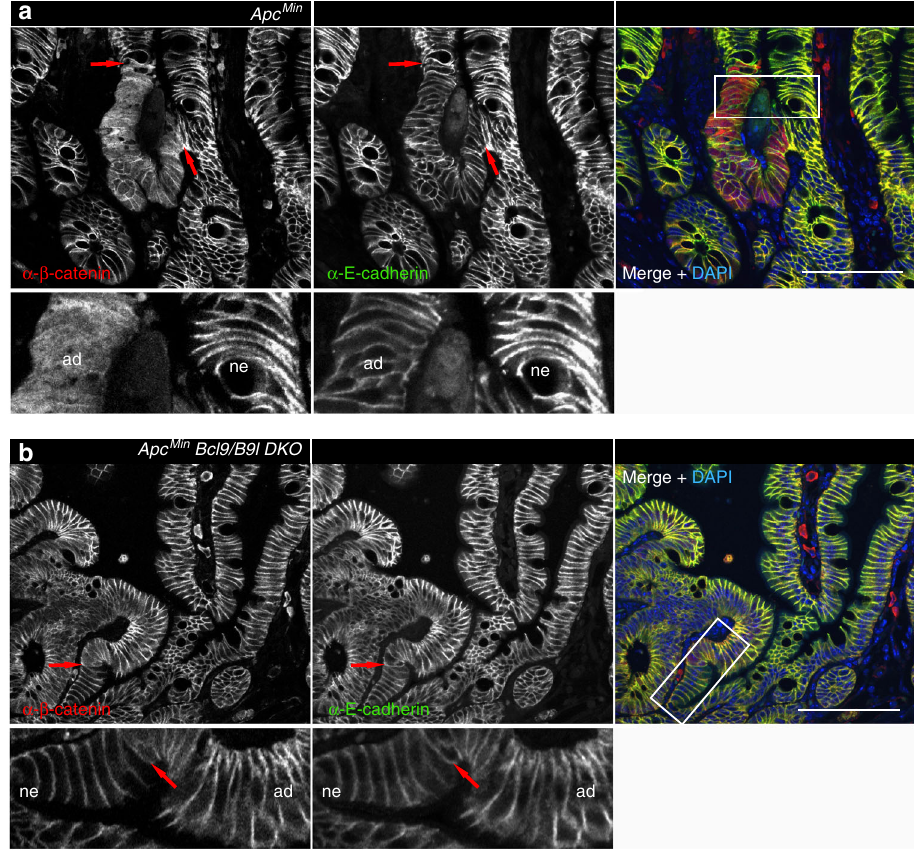
Fig. 5 Loss of Bcl9 causes relocation of β -catenin to the cell surface of Apc Min adenoma cells. IF of nascent adenomas from a Apc Min or b Bcl9/B9l DKO small intestines, after fi xation and double-staining as in Fig. 1d – f; arrows , boundaries between normal epithelium ( ne ) and adenoma ( ad ); underneath, magni fi ed views of squares (in merges, right ) containing comparable normal and adenomatous epithelial cells; blue , nuclei marked by DAPI (only in merges); scale bars, 50 μ m. Note the high levels of nucleocytoplasmic β -catenin in Apc Min adenomas (strong red fl uorescence in ( a ); see also Fig. 1e, f), relocated to the cell surface in Bcl9/B9l DKO adenomas (yellow fl uorescence in b ), leaving barely any discontinuities between adenomatous and adjacent normal epithelial